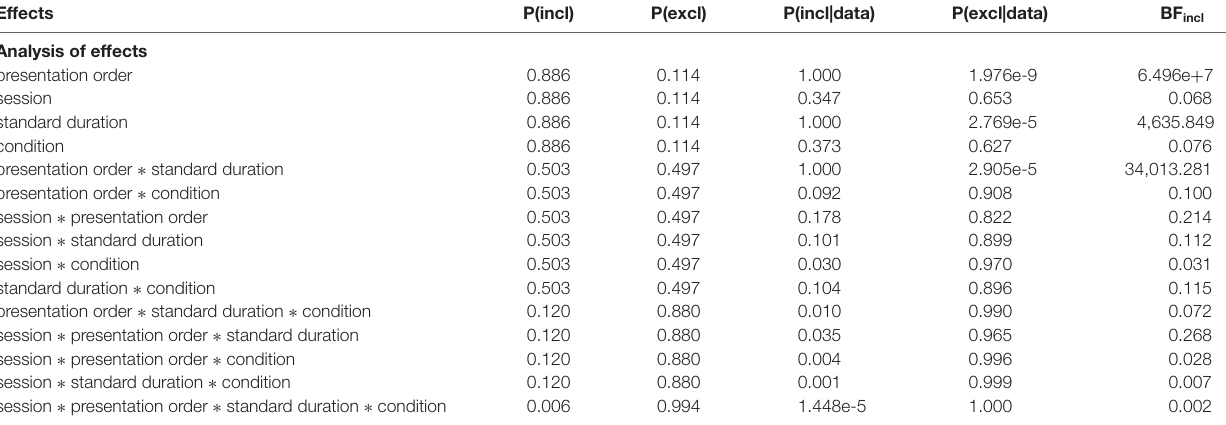
TABLE 1 | Bayes factors for inclusion calculated based on Bayesian model averaging for PSEs of Experiment 1.